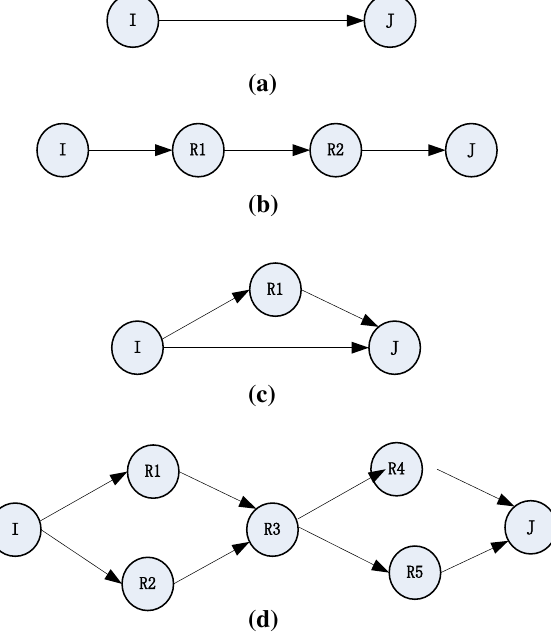
Figure 5. The probability of contact in different